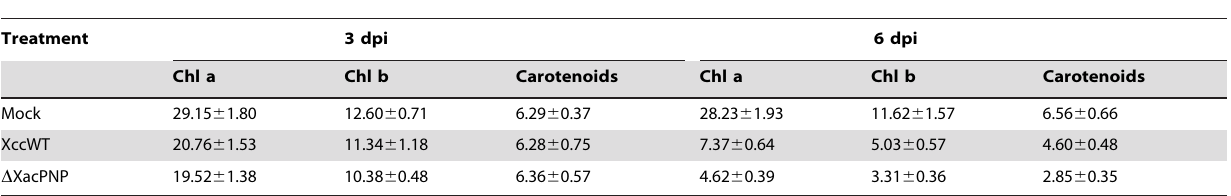
Table 2. Pigments content of infiltrated citrus leaves.